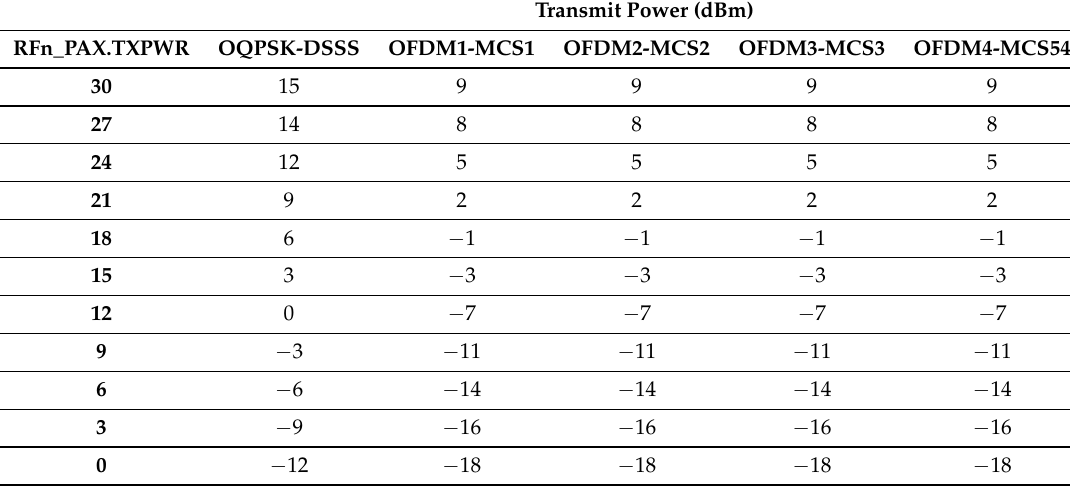
Table 3. Transmit power values for the OQPSK-DSSS and the SUN-OFDM modulations. Notice that the results have been rounded to the closest dB given the resolution of the DUT (Device Under Test) and the uncertainty of the TE (Test Equipment).